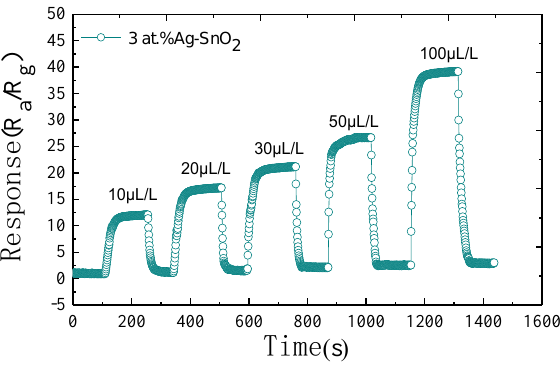
Figure 9. Dynamic response-recovery curve of the 3 at.% Ag-doped SnO 2 sensor to H 2 in a range of 10–100 µL/L under its optimum working temperature.